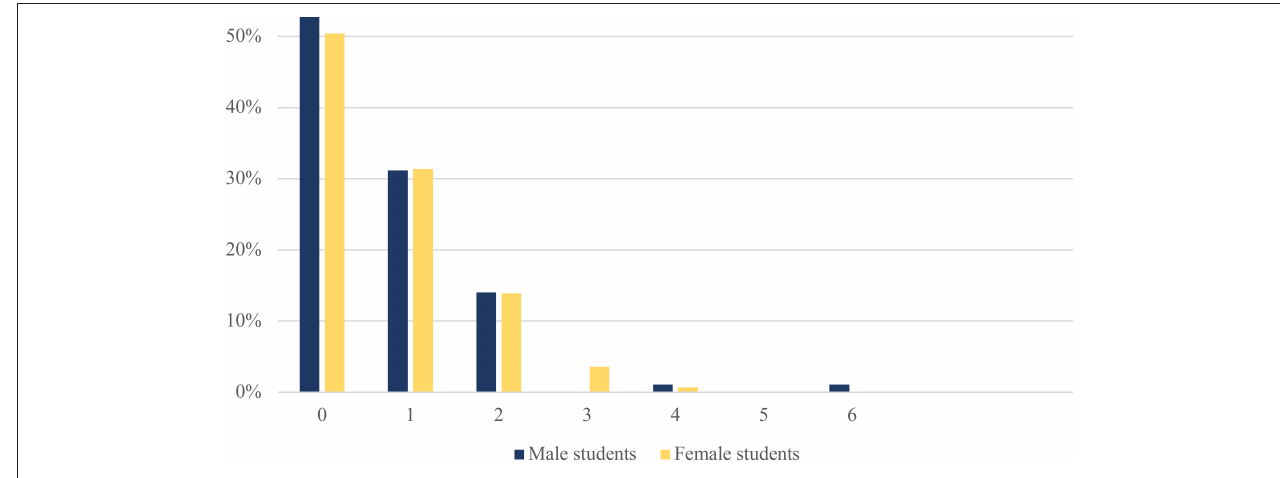
FIGURE 1 | Proportion of adolescents [male ( n = 93) and female ( n = 137)] reporting different number of somatic